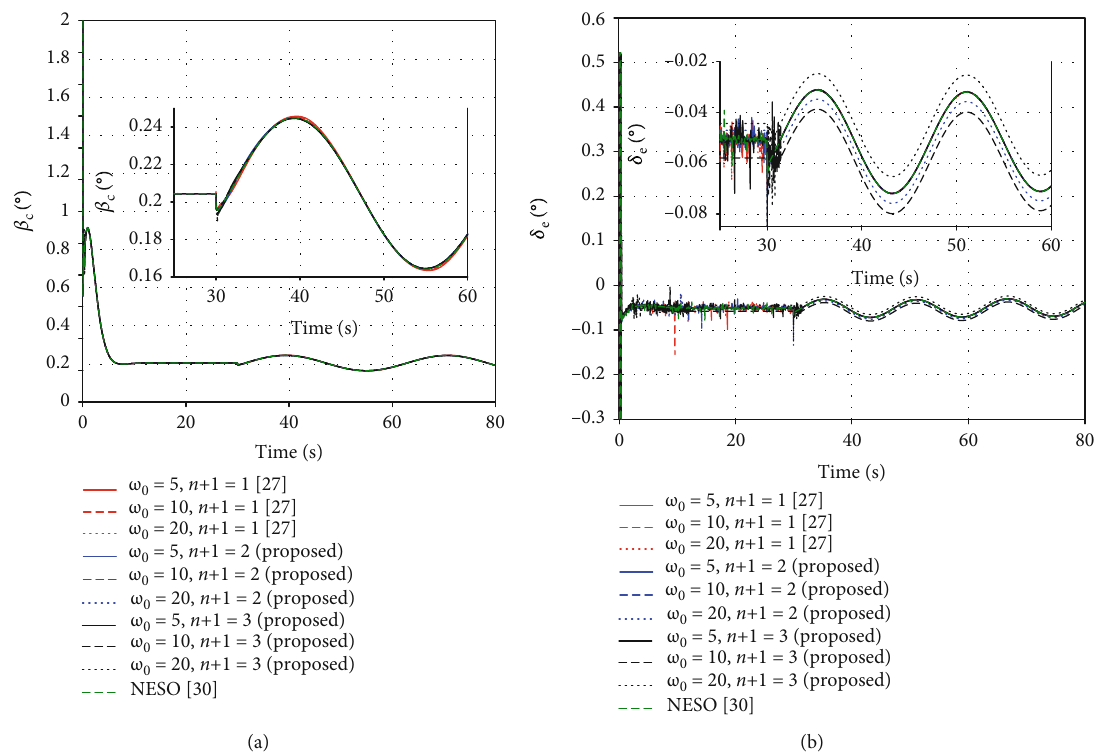
Figure 7: Actuator response curve: (a) throttle setting; (b) elevator de fl